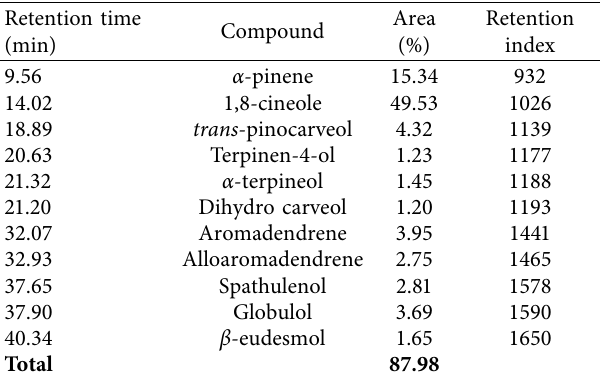
Table 1: Identified ingredients ( > 1%) in EGEO using GC-MS analysis.